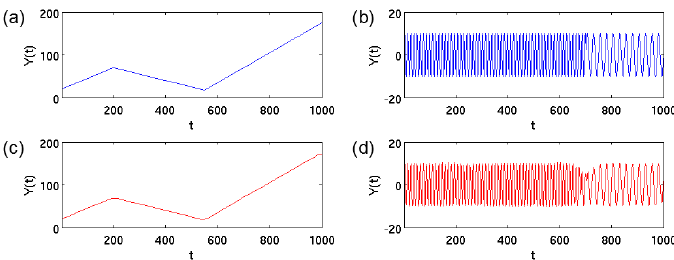
Fig. 9. The realizations of (a) (cid:11)t and (b) A sin( 2 (cid:25) the representative time series of (c) ~Y I